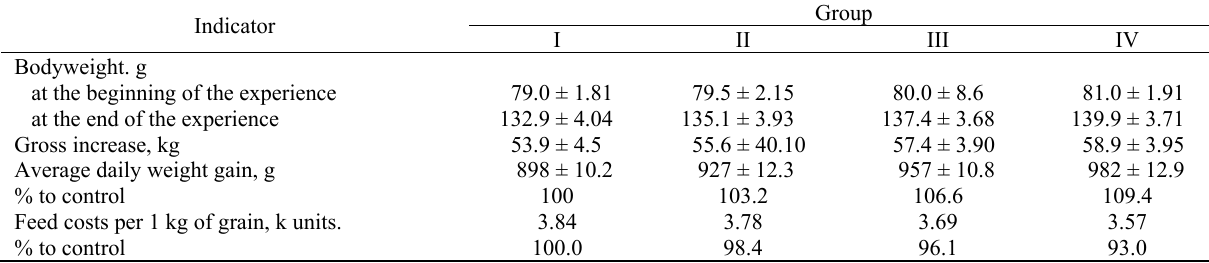
Live weight and average daily gain of experience animals